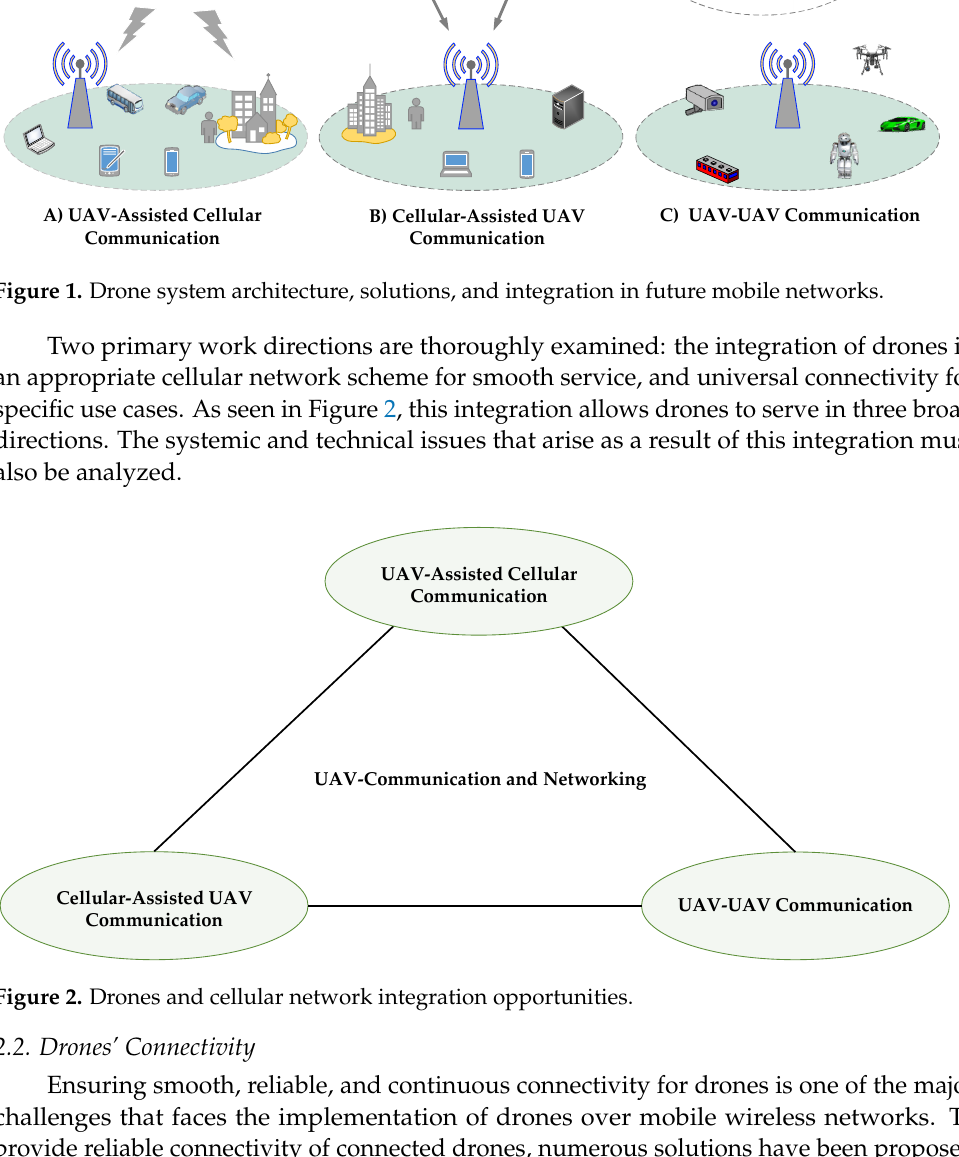
Figure 1. Drone system architecture, solutions, and integration in future mobile networks.